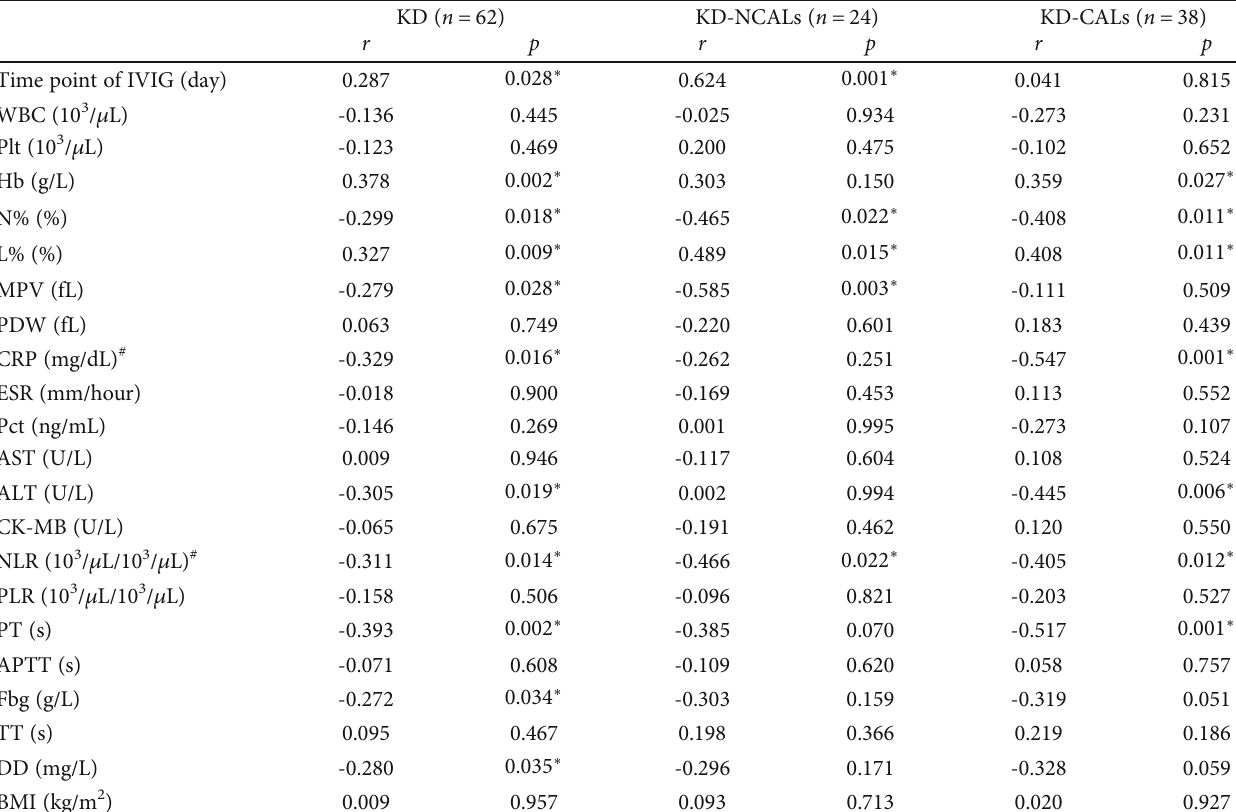
Table 2: Correlations of RBP4 with clinical and laboratory variables in KD patients.